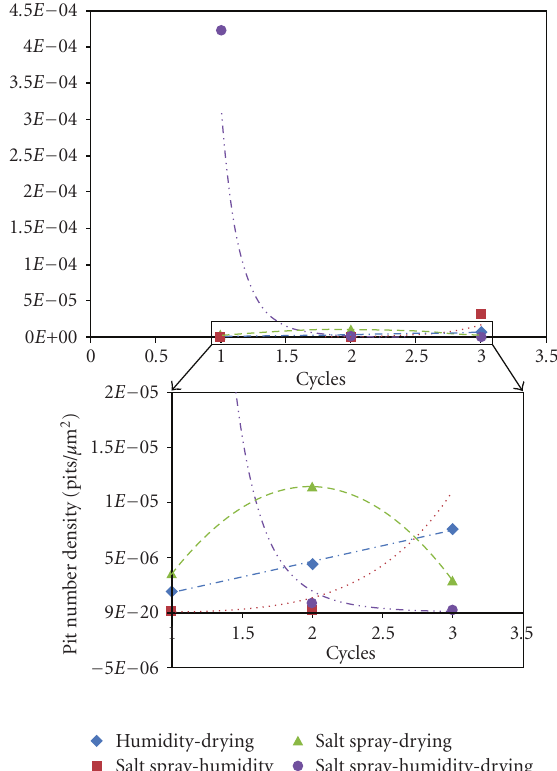
Figure 3: Average pit number density of the AE44 coupons arranged by test condition based on cycle number. Please note that the second graph was produced by focusing on the box surrounding the values close to the x -axis, in order to ensure that the values close to zero could be seen